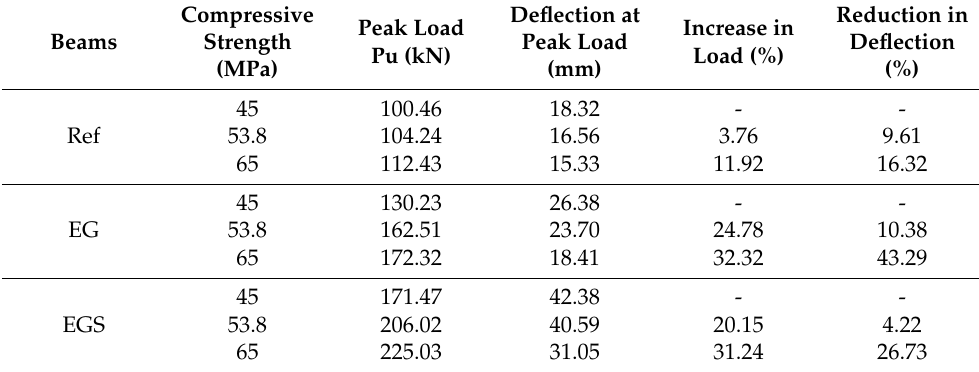
Table 9. Effect of the Concrete Compressive